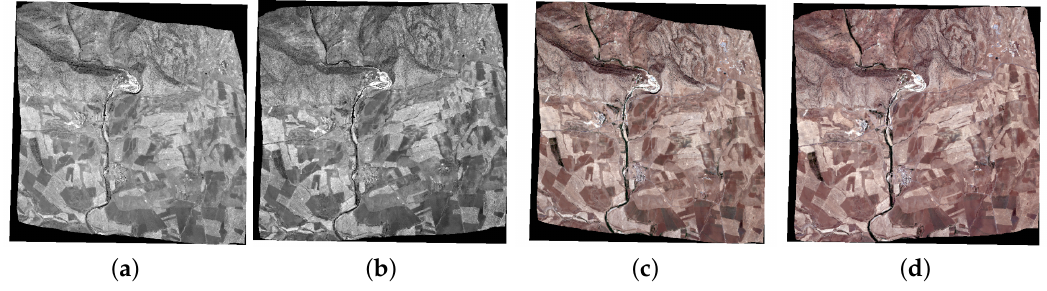
Figure 7. Stereo-pair images from Pleiadés. ( a , b ) panchromatic images; ( c , d ) multispectral